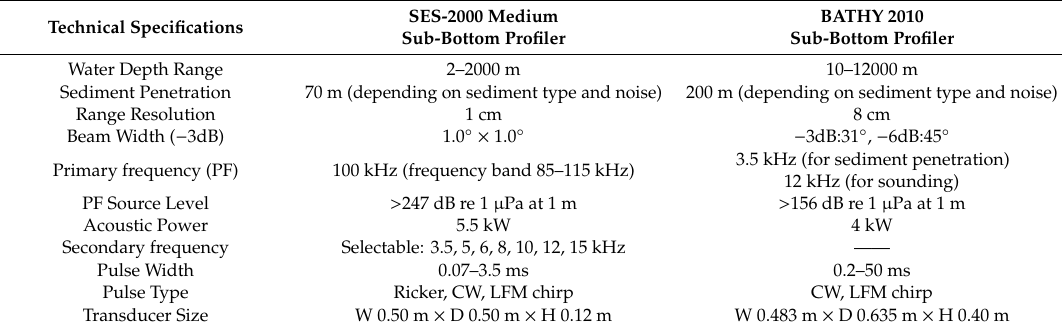
Table 1. Comparison of technical specifications of sub-bottom